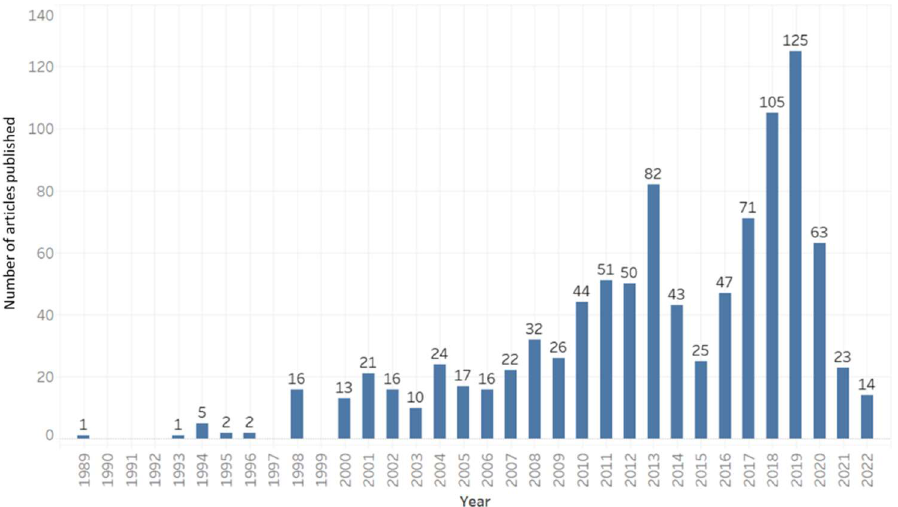
Figure 3. Bar chart depicting the growth in SRP grantee publications related to climate change over time. Note: historical publications are more difficult to attribute to SRP funding as grant reporting requirements for publications were not in effect, thus earlier data are likely an underestimate SRP